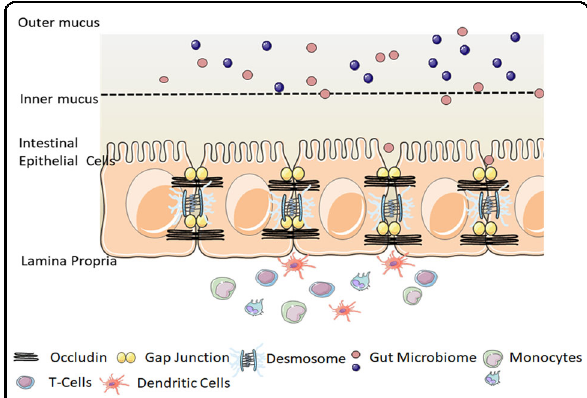
Fig. 1 Intestinal epithelial barrier. Epithelial cells form a layer that functions as a physical barrier facilitated by tight connections between each cell. A number of tight junction protein components seal the paracellular pathway and conduct gate and fence functions. The mucosal layer is a chemical barrier that is critical to limit the contact between the microbiome and epithelial cells. Immune cells are also a major participant in the immune response and the tolerance of the host against external substances. The graphical illustration was drawn by using the images from Servier Medical Art by Servier, with slight modi fi cations (http://www.servier.com/Powerpoint-image-bank,